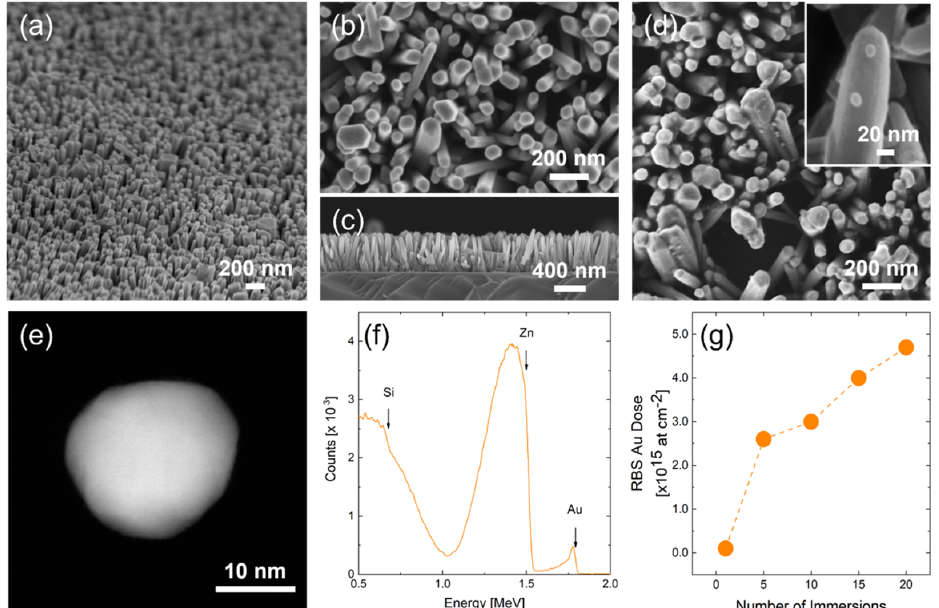
Figure 1. ( a ) Tilted SEM images of bare ZnO NRs; ( b ) magnified SEM image of ZnO NRs and ( c ) cross section SEM image of ZnO nanostructured film; ( d ) SEM images at different magnifications of Au 20 -ZnO; ( e ) STEM image of a Au NP; ( f ) RBS spectrum of the Au 20 -ZnO sample; ( g ) variation of the Au loading on the surface of ZnO NRs as a function of the number of immersions.